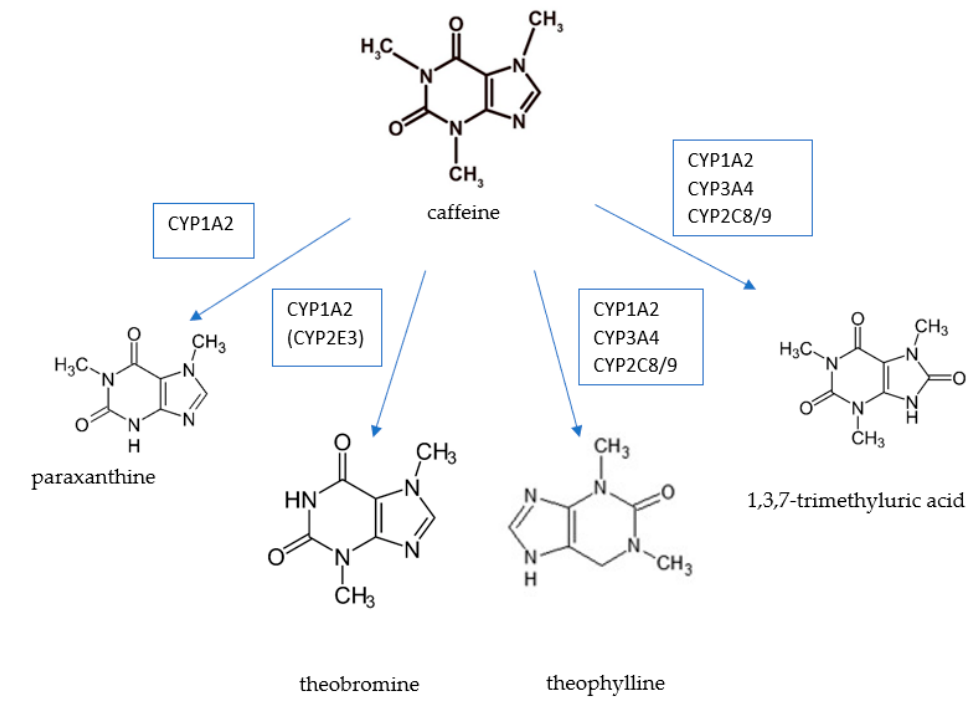
Figure 1. Caffeine metabolism. Source: own elaboration based on: [12].